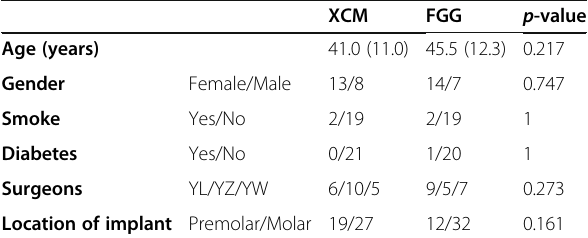
Table 3 PROMs during the early healing